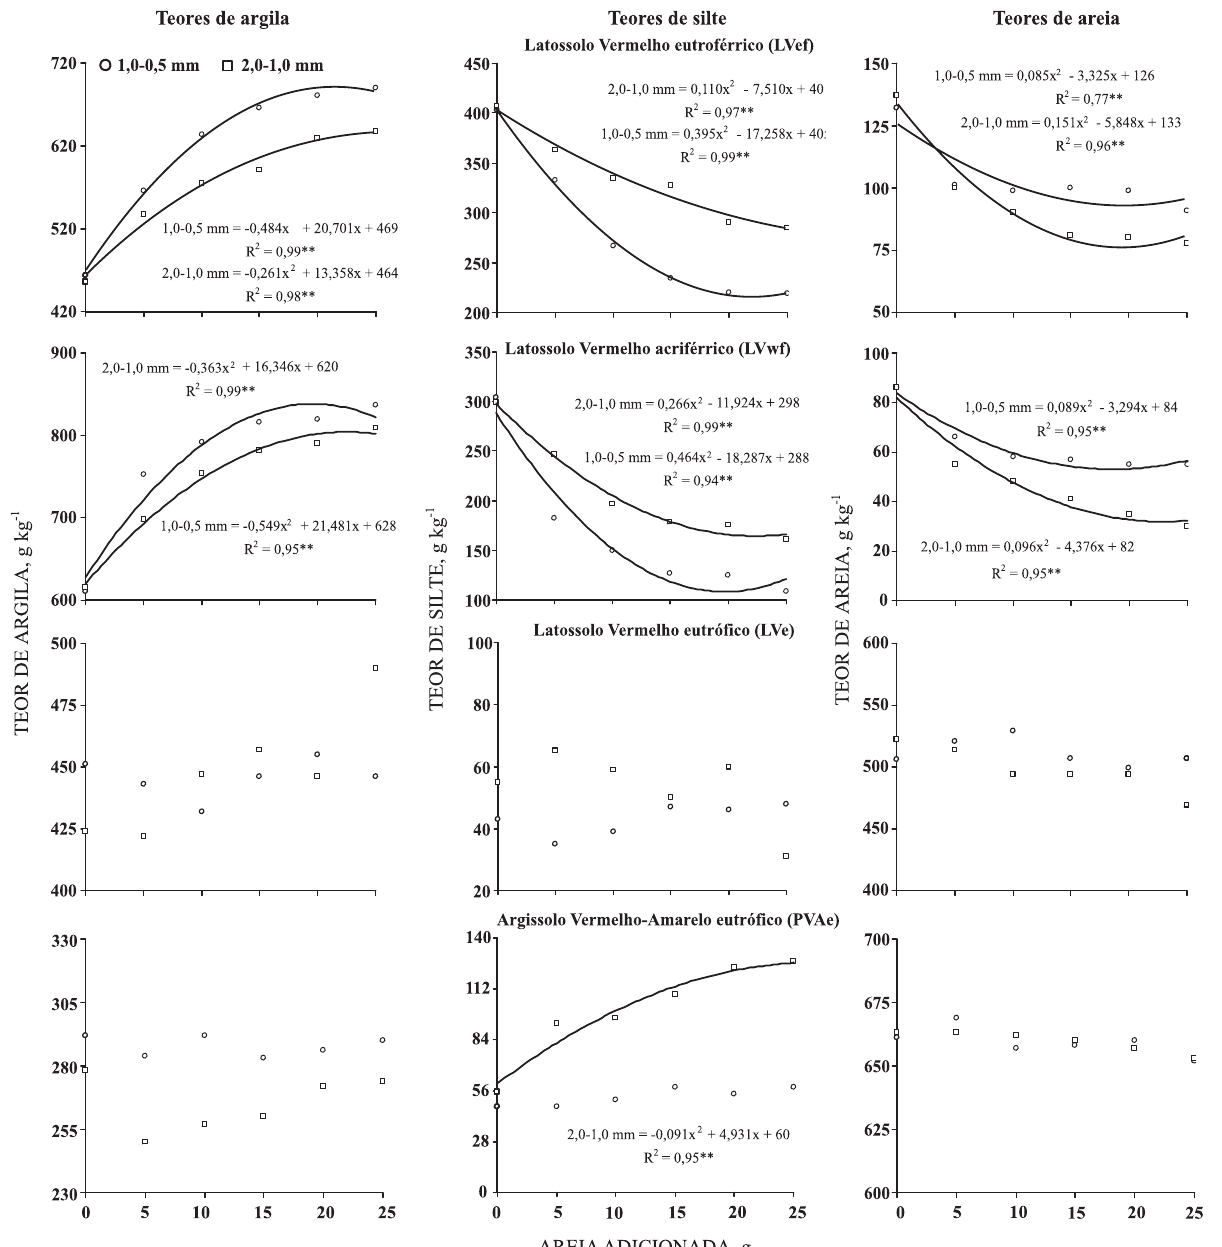
Figura 1. Efeito da adição de areia com diferentes tamanhos nos teores de argila, silte e areia do Latossolo Vermelho eutroférrico (LVef), Latossolo Vermelho acriférrico (LVwf), Latossolo Vermelho eutrófico (LVe) e Argissolo Vermelho-Amarelo eutrófico (LVAe). **: significativo (p <